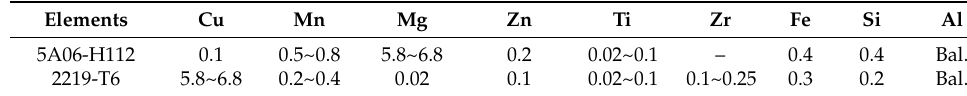
Table 1. The chemical composition of alloys (wt.%).